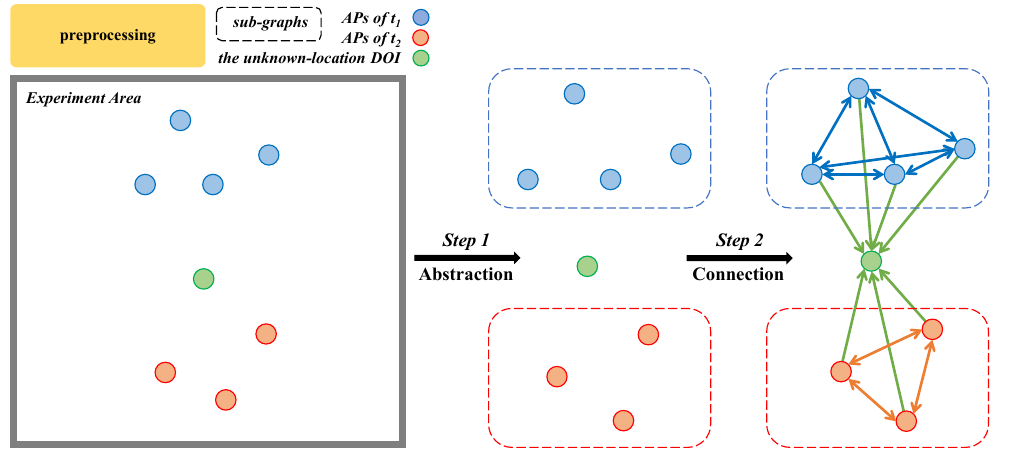
Figure 6. The fingerprint-graph transformation method proposed in our prior work [74], instantiated = 2 as an example. T for | |